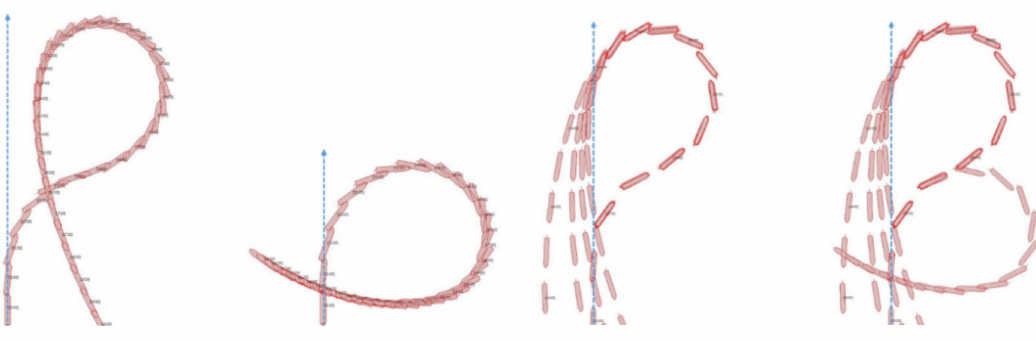
Figure 11. Williamson turn ( far left ), Anderson turn ( 2nd left ), and modified turns ( overlaid ).